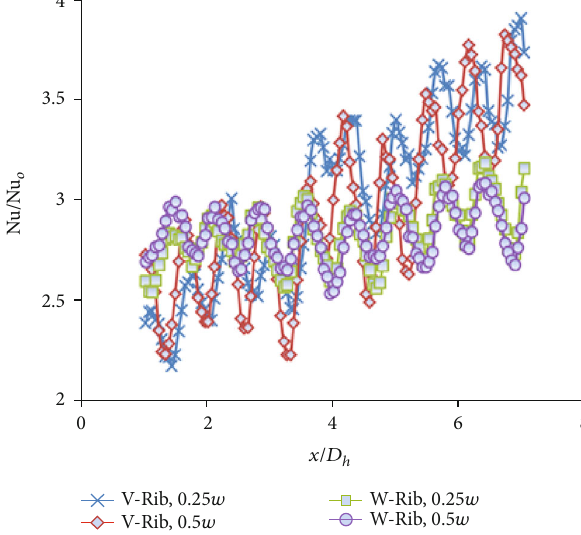
Figure 7: Streamwise variation of Nu/Nu